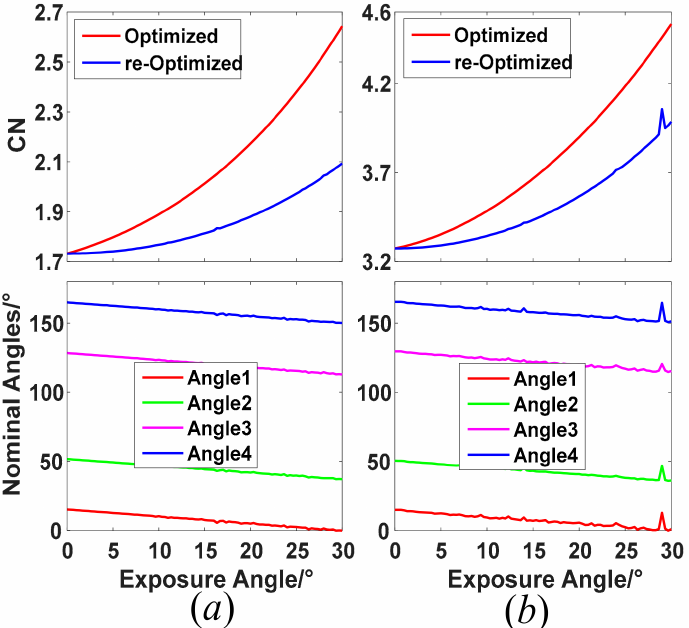
Figure 3. Re-optimized CN and its corresponding nominal angles. ( a ) retardance of 132 ◦ ; ( b ) retardance of 90 ◦